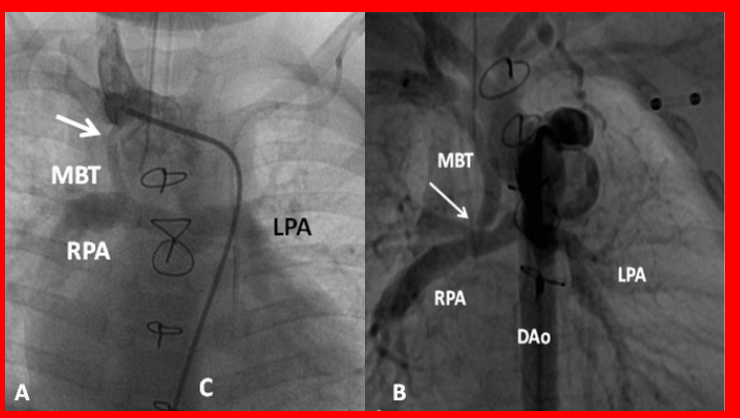
Figure 37. ( A ) Selected cine frame in a postero–anterior view demonstrating narrowing (arrow) of